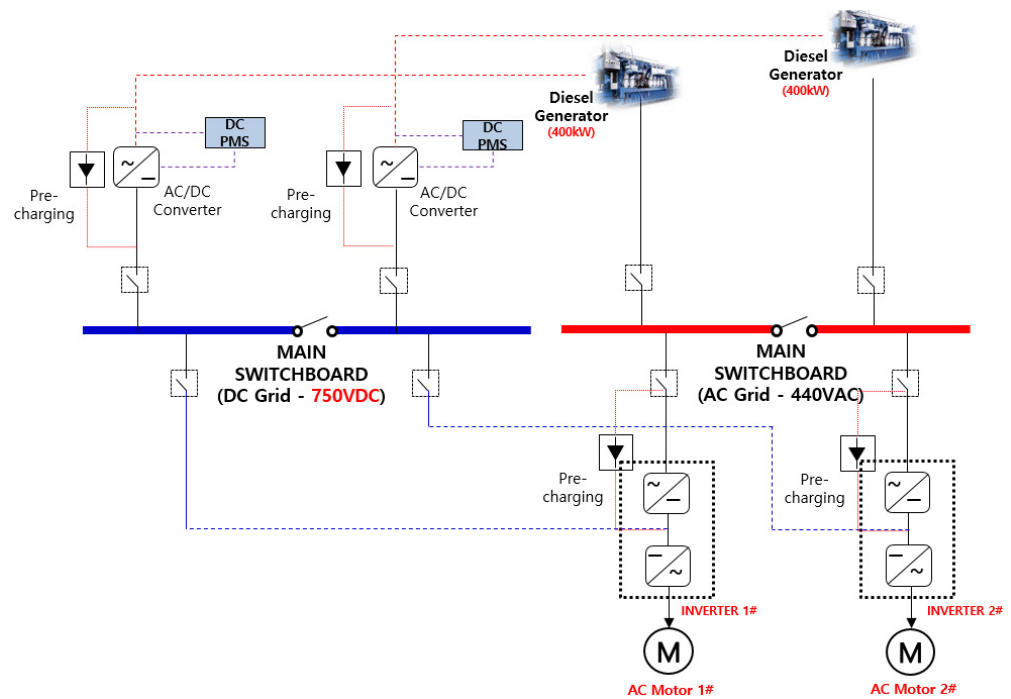
Figure 6. Configuration of the AC-DC hybrid distribution electric propulsion system for the testbed.